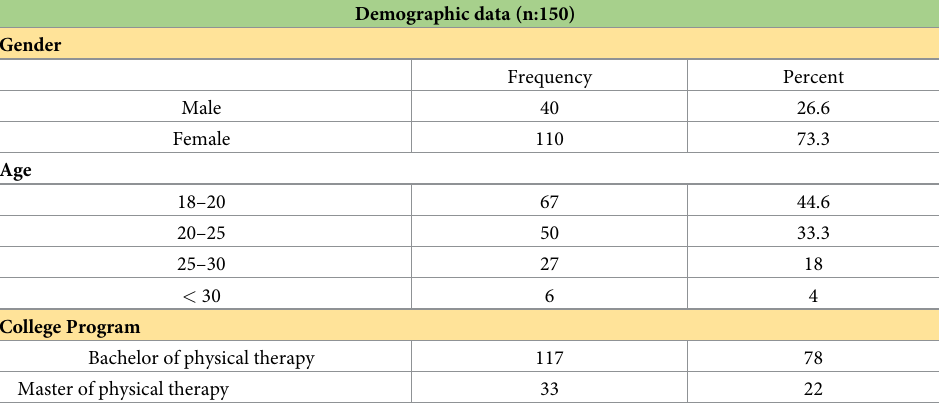
Table 1. Demographic data of all